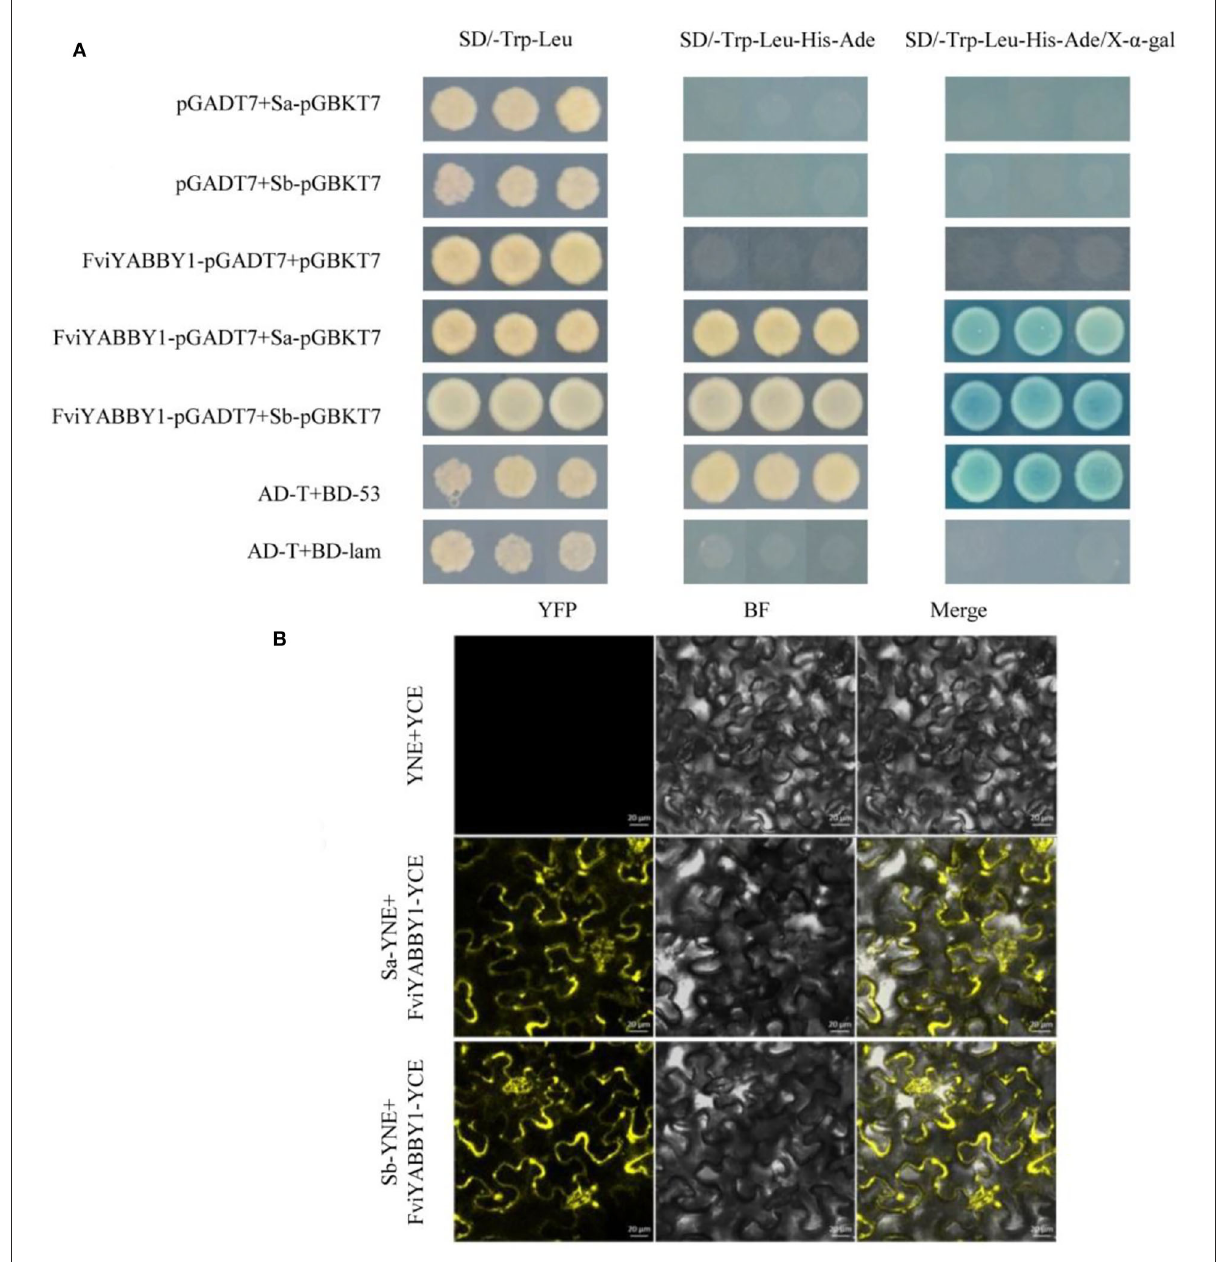
FIGURE8 Interaction between FviYABBY1 and S a -RNase/S b -RNase. (A) Yeast two-hybrid assay. (B) Bimolecular fluorescence complementation (BiFC) assay. YFP, yellow fluorescence protein; BF, bright field; Merge, merged image of YFP and BF. Bar = 20 µ m.